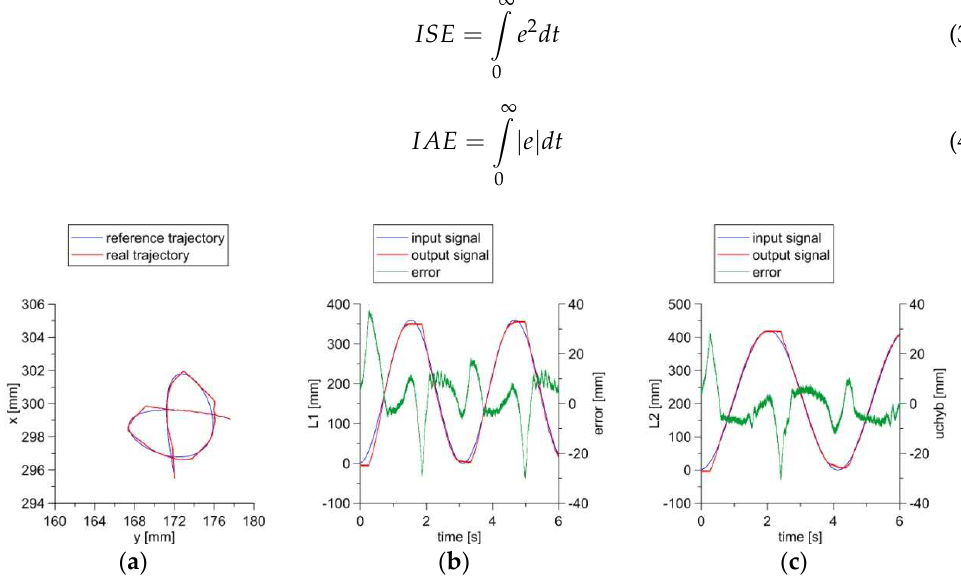
Figure 8. The positioning of the manipulator end effector along a bow-shaped trajectory: ( a )